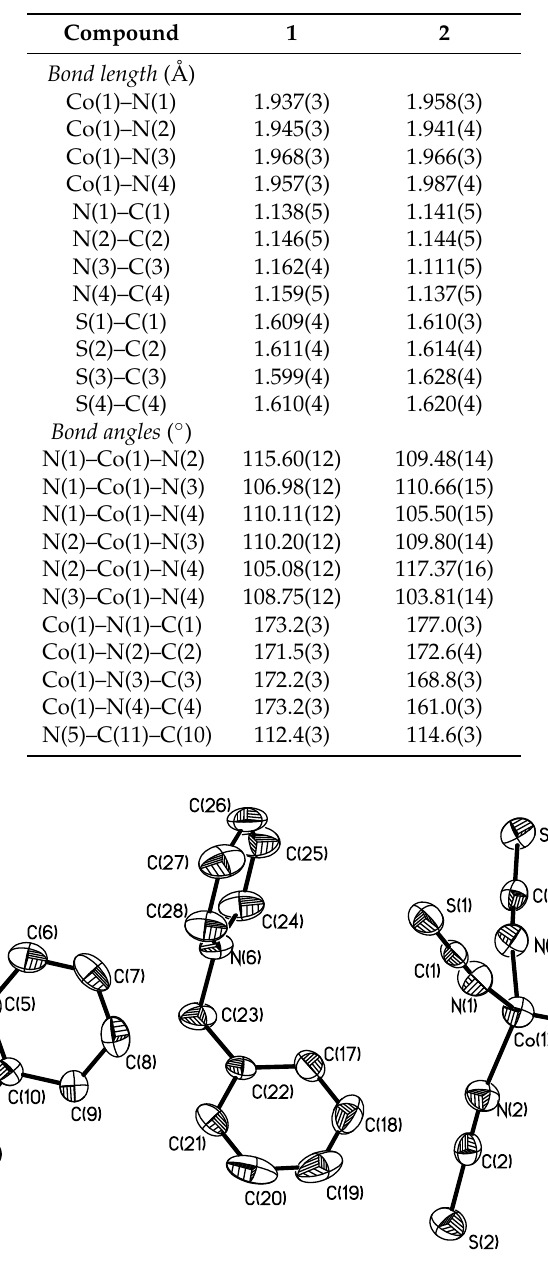
Table 1. Selected bond lengths and bond angles for 1 and 2 .